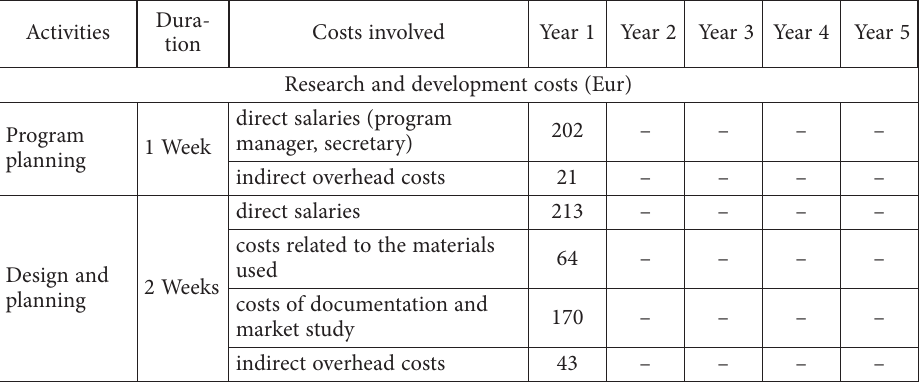
Table 2. Costs related to the introduction of a licensing